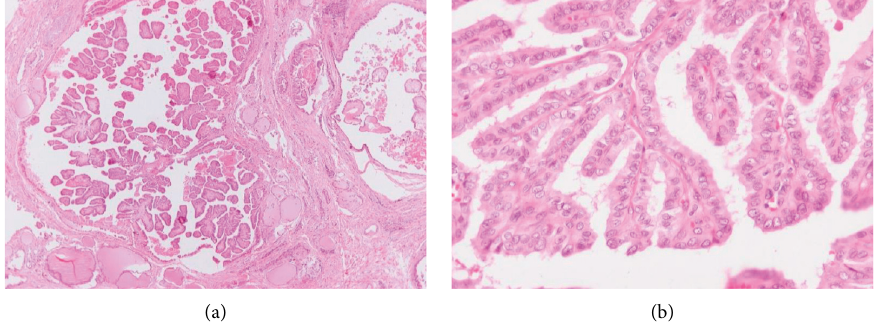
Figure 1: (a) ( × 40) Papillary structures typical of papillary thyroid carcinoma filling cystic spaces. (b) ( × 400) Papillary structures are lined by medium-sized cells with eosinophilic cytoplasm and nuclear features typical of papillary thyroid carcinoma.